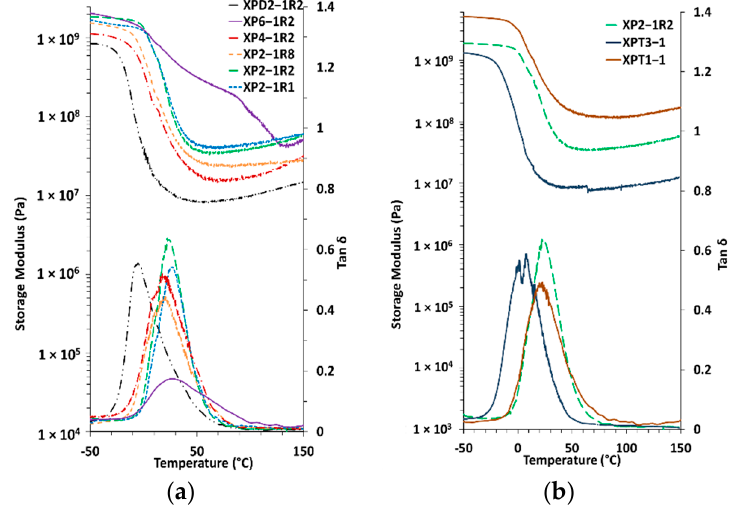
Figure 5. DMA spectra of the organic–inorganic networks. Storage modulus and tan δ evolutions are given in the top and the bottom of the spectra, respectively. ( a ) corresponds to Series 1, 2, 3 and ( b ) to Series 4.